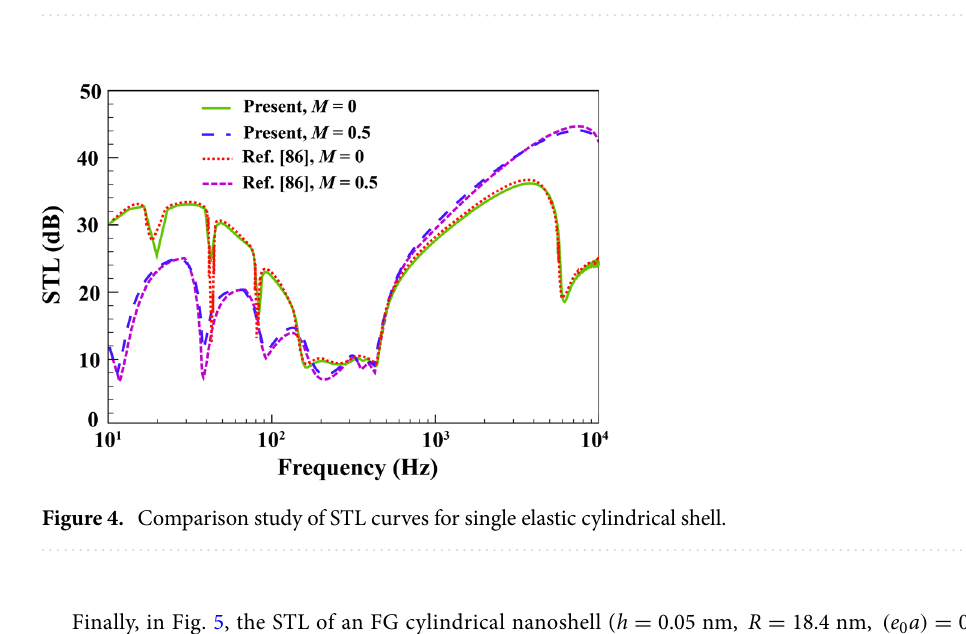
Figure 3. Comparison study of STL curves for a PZ nanoshell.